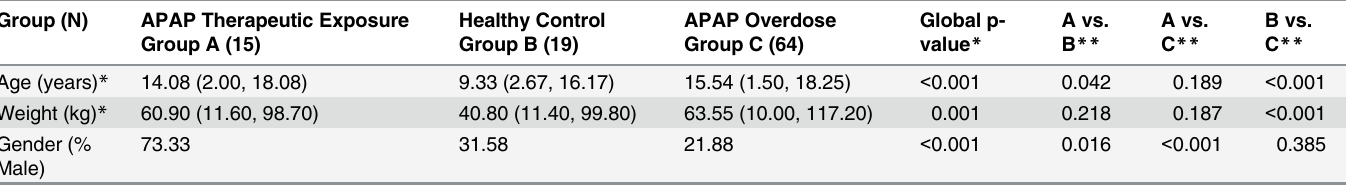
Table 1. Demographic characteristics of study subjects by